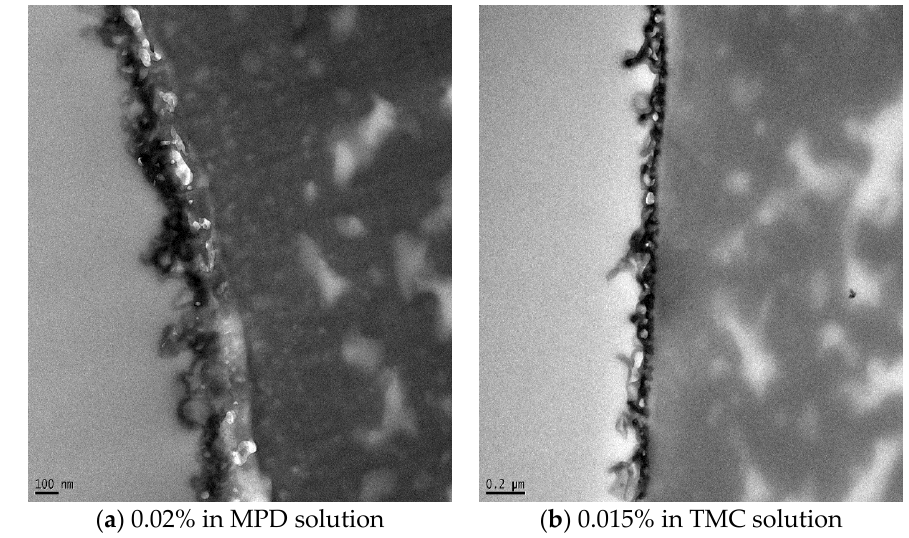
Figure 3. TEM images of the membrane made by adding 0.02% NPs in MPD ( a ) and 0.015% NPs in TMC ( b ).